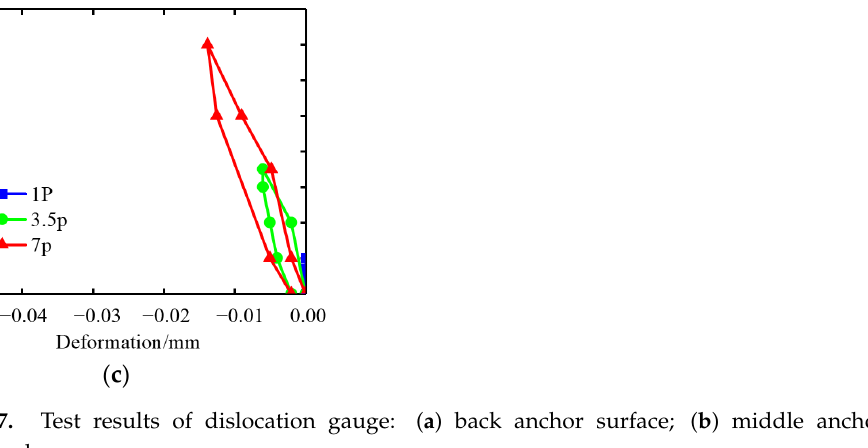
roof at the front anchor surface and the tunnel face increases with the increase of load. When applied to an 8P load, the surrounding rock deformation produces an inflection point. Therefore, based on the test results of surrounding rock deformation in the model experiment, the bearing capacity of the tunnel anchor is determined as 8P. In summary, under the action of load, the anchor plug body drives the surrounding rock mass to pro- duce pull-out failure. The potential failure mode is that under the action of a large over- load, the anchorage body and the surrounding rock mass are pulled out as a whole, and the failure mode is shown in Figure 19. Figure 19. Diagram of potential failure model of tunnel anchor. 6. Conclusions In this paper, Wujiagang Bridge’s north side of the river tunnel anchor was used as the background of the study. A 1:12 scale model of the tunnel anchor was constructed based on the similarity principle at the site adjacent to the project site with the same geo- logical conditions using a field-scale model test. The scale model experiments such as de- sign load test, overload test, overload rheological test, and ultimate bearing capacity fail- ure were carried out by using comprehensive test methods such as displacement meter, inclinometer, strain gauge, and micrometer, and the following research conclusions were obtained.